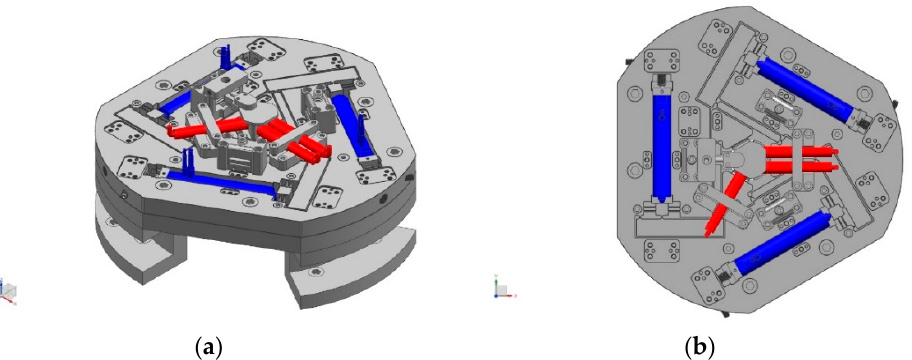
Figure 1. In-plane actuators and sensors of the proposed spatial nanopositioner. ( a ) 3D view; ( b ) top